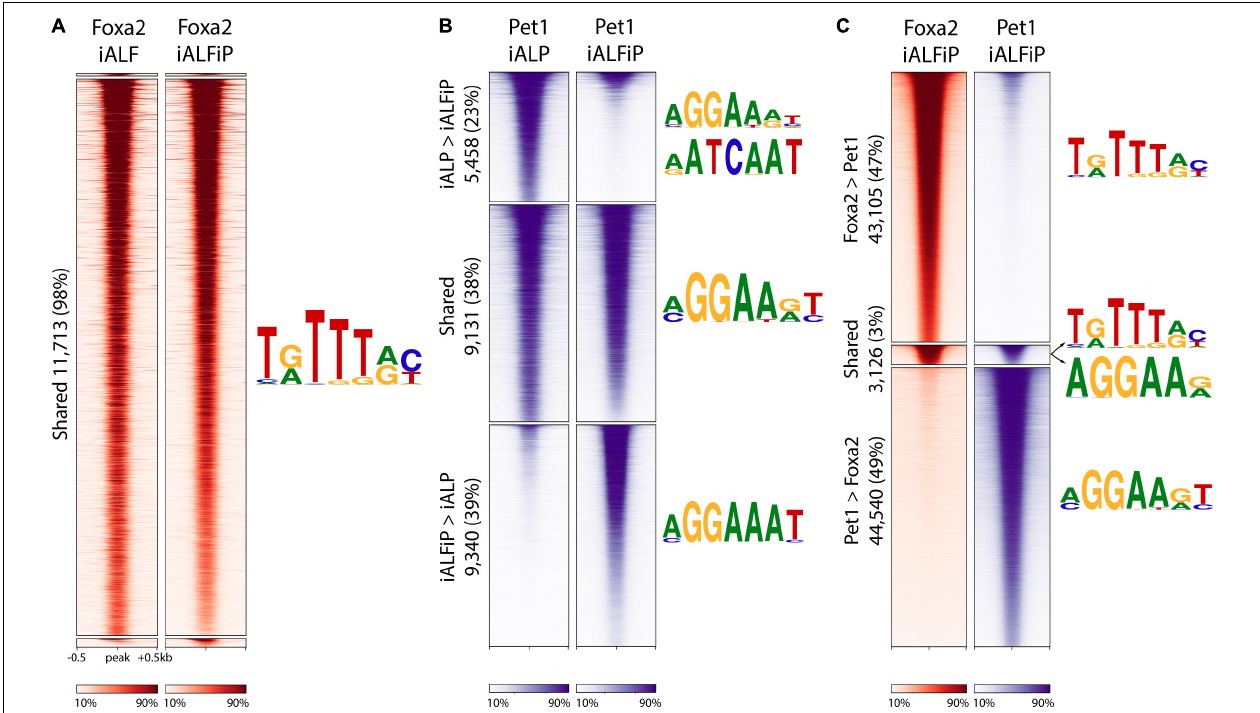
FIGURE 4 | The presence of Foxa2 affects the location of Pet1 binding. (A) Heatmap of ChIP-seq reads at Foxa2 binding sites in ALF and ALFiP induction backgrounds after 12 h. A 1 kb window around the peak center is plotted. The plots are divided top-to-bottom based on the preferential binding patterns ALF > ALFiP, shared, and ALFiP > ALF, according to MultiGPS. The sequence logos of the motifs detected by MEME-ChIP are shown to the right of the region. (B) Heatmap of ChIP-seq reads of Pet1 binding sites in ALP and ALFP background. (C) Heatmap of ChIP-seq reads at Foxa2 (red) and Pet1 (blue) binding sites in ALFP background. The color scaling in all heatmaps vary between the read counts observed in the 10th and 90th percentiles of